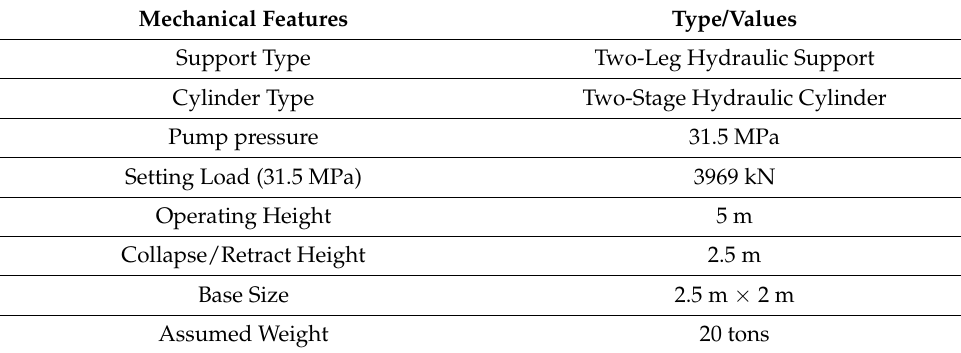
Figure 3. Equipment dimension. ( a ) Two-stage hydraulic support; ( b ) telescopic cylinder (performed by the authors). Table 1. The hydraulic support system